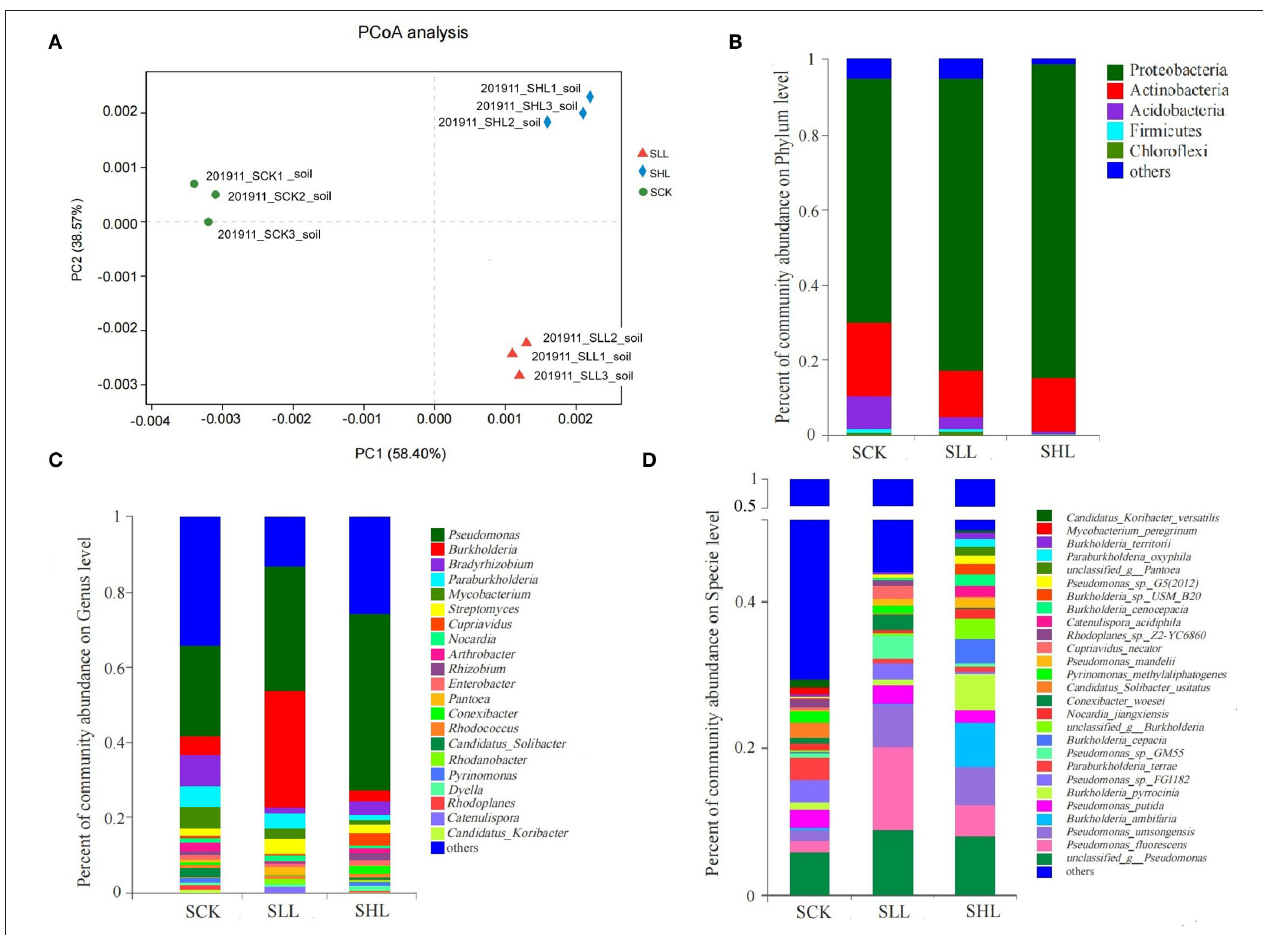
FIGURE 4 | Taxonomic composition of HLB-infected citrus rhizoplane microbiome. (A) Principal-coordinate analysis (PCoA) based on bray_curtis distances for the rhizoplane microbiome in acidified (SCK) or amended soils (SLL and SHL) at the specie level. Taxonomic distribution at the Phylum (B) , Genus (C) , and Specie (D) level in HLB-infected citrus rhizoplane soil samples. SCK, soil without lime treatment; SLL, soil treated with low-level lime; SHL, treated with high-level lime. Taxa with < 1% of reads were combined together as